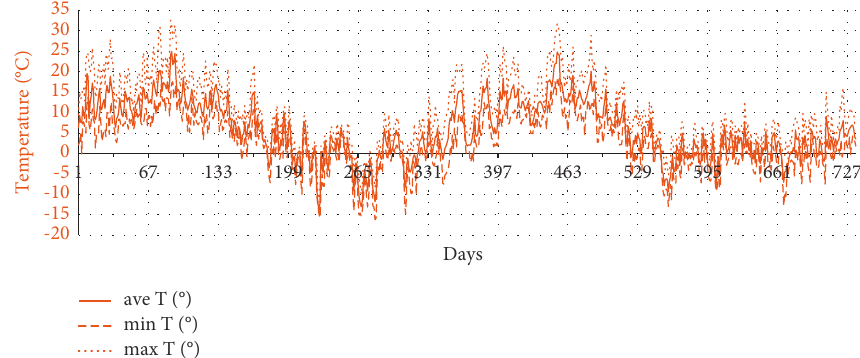
Figure 9: Climatic conditions for the two-year time span: average, minimum, and maximum temperature.